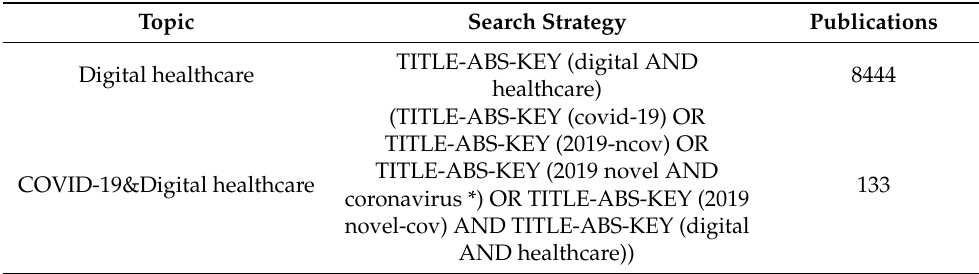
Table 1. Search strategy for publications on digital healthcare from Scopus. Topic Search